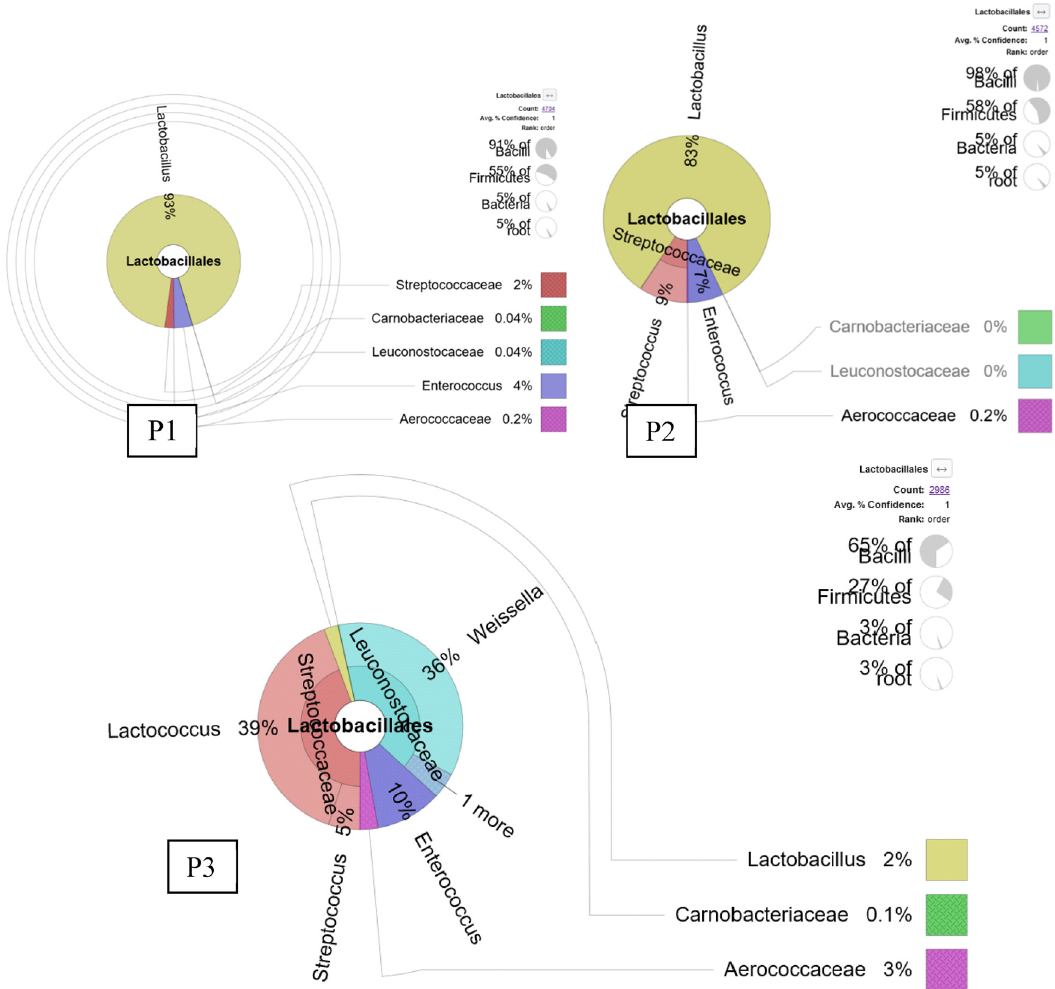
Figure 1: KRONA visually displays the analysis result of taxonomic annotation. Circles from inside to outside stand for di ff erent taxonomic ranks, and the area of the sector means a respective proportion of di ff erent OTU annotation results. The abundance of Lactobacillus spp. Was detected from the rearing water of commercial shrimp ponds on the day of culture ( DOC ) 47. P1 is pond 1, P2 is pond 2, and P3 is pond